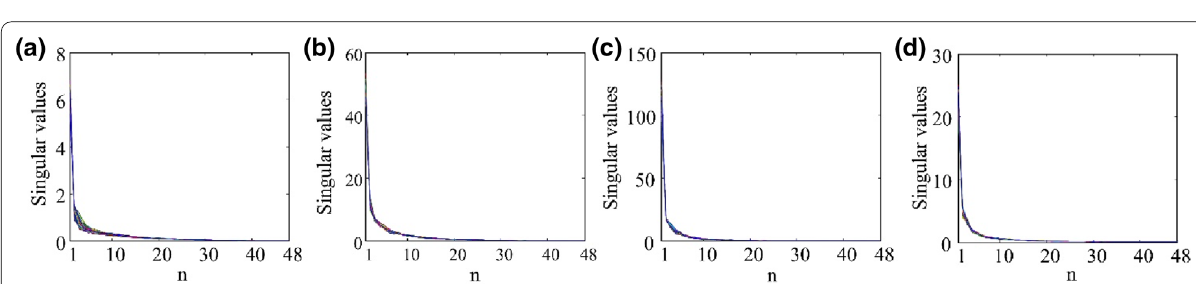
Figure 10 Singular values obtained by GST and SVD: ( a ) normal, ( b ) IRF, ( c ) ORF, ( d )